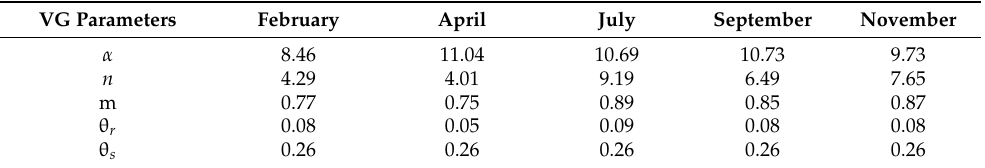
Table 1. The estimated relative parameter of Brooks–Corey from the time-lapse ERI survey at the PT06 site for five different months of 2019.